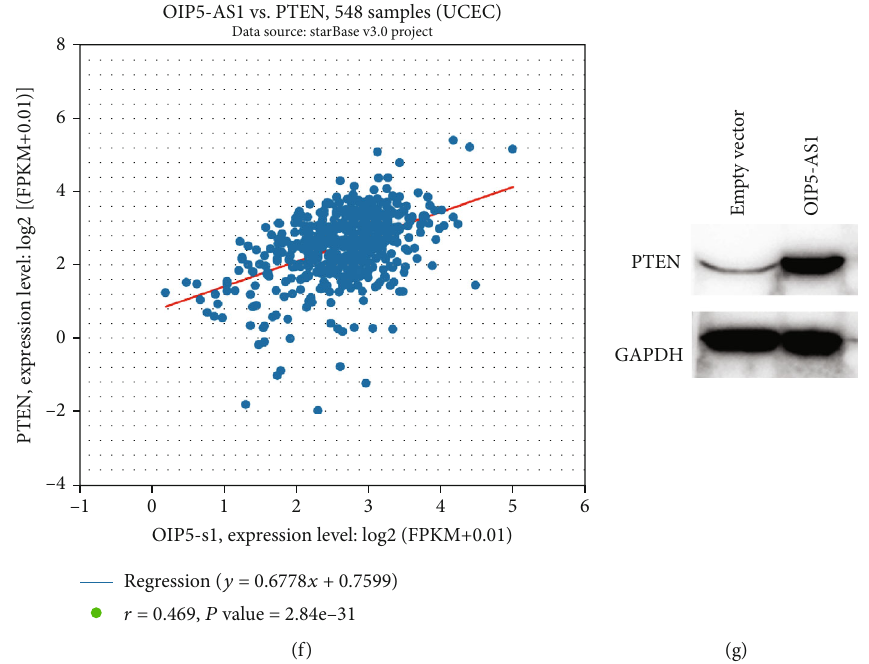
Figure 6: PTEN controls the progression of endometrial cancer by acting on a ceRNA of PTEN by sponging miR-200c-3p. (a) CCK8 assay was conducted to assess miR-200c-3p ’ s in fl uence on the HEC-1-A cell. (b, c) EDU staining images revealed that miR-200c-3p could promote proliferation, and coexpressing OIP5-AS1 could alleviate the e ff ect caused by miR-200c-3p. (d) Transwell assay indicated that miR-200c-3p could facilitate tumor invasion. (e) Western blot of PTEN and AKT when miR-200c-3p and OIP5-AS1 are altered. (f) Data mining using the TCGA database exhibited a positive correlation between PTEN and OIP5-AS1. (g) Western blot assay proved the OIP5-AS1 overexpression upregulation of the level of PTEN in the HEC1A cell